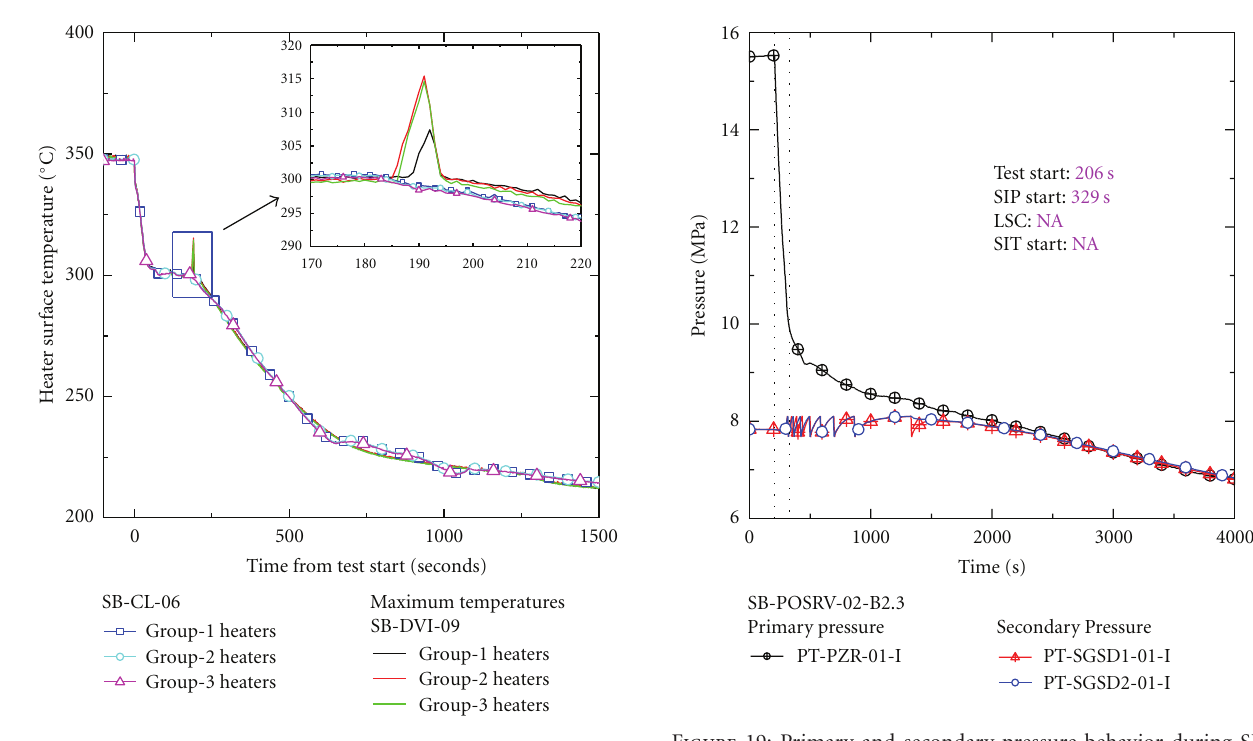
Figure 17: Comparison of cladding temperatures between SB-DVI- 09 and SB-CL-06.